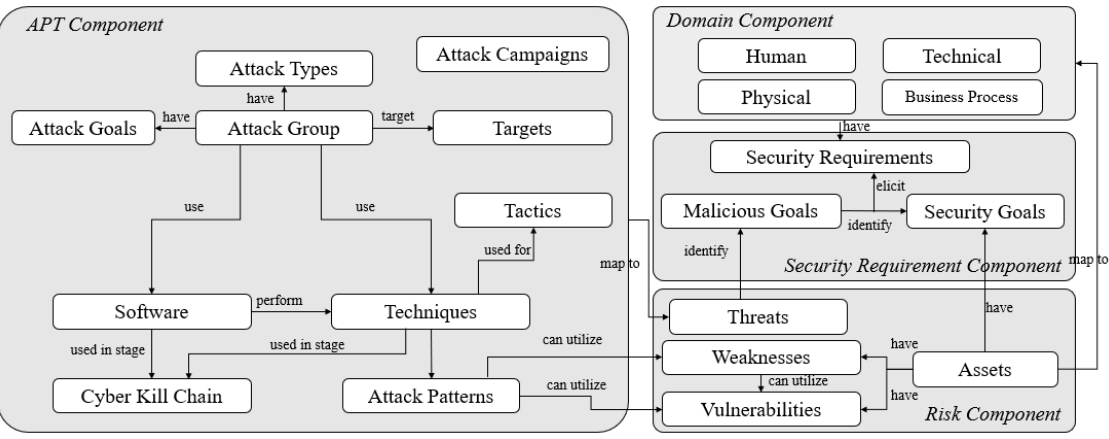
Figure 4. Conceptual model of CB-PDO.